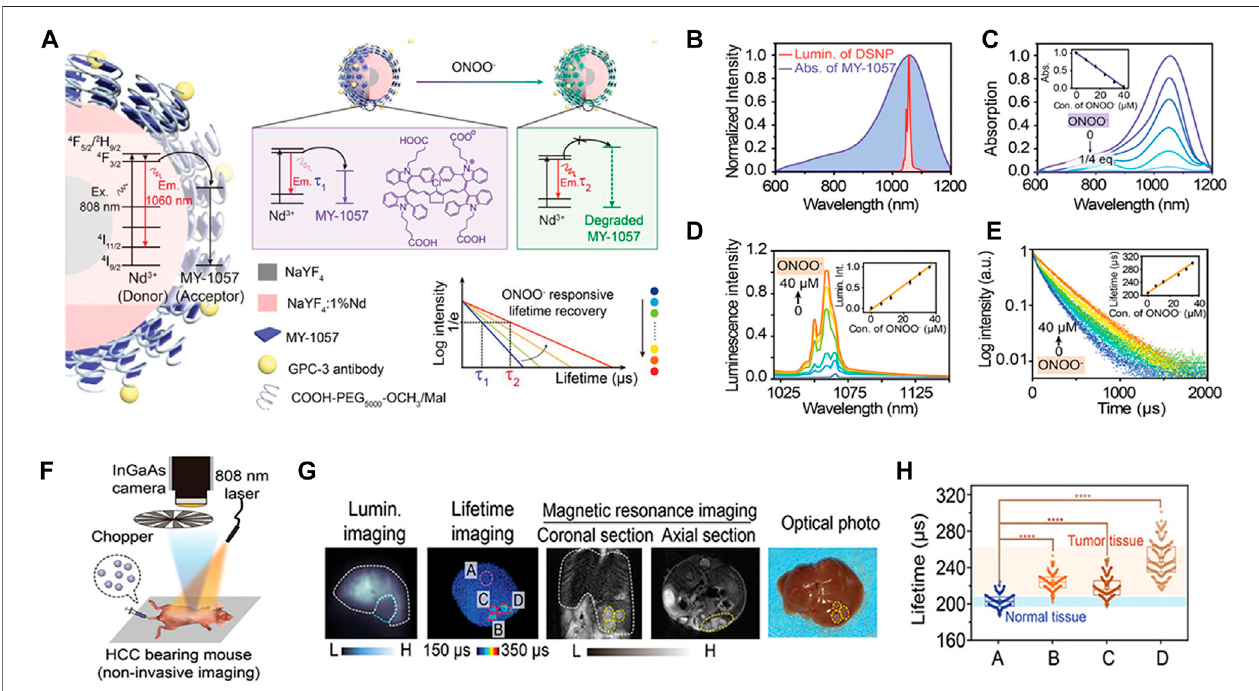
FIGURE 10 | Lifetime-resolved imaging for ONOO − dectection. (A) Schematic illustration of the ONOO − -responsive nanosensor DSNP@MY-1057-GPC-3. In the presence of ONOO − , the structure of the energy acceptor MY-1057 degrades sensitively, leading to the lifetime recovery in NIR-II region. (B) Overlap of the MY-1057 absorption and DSNP luminescence emission spectra. (C) Absorption of MY-1057 as a function of ONOO − (0 – 1/4 equiv.). (D) Luminescence emission intensity and (e) lifetimeresponseofDSNP@MY-1057-GPC-3at1,060 nmasafunctionONOO − concentration. (F) Insitu HCCtumordetectionbynoninvasiveimagingsetupafter administration of DSNP@MY-1057-GPC-3 nanosensor. (G) Noninvasive intensity-based imaging, lifetime-based imaging of a mouse bearing multiple HCC lesions and optical photo of the dissected liver. ROI A: normal hepatic tissue; ROIB – D: tumor lesions distinguished from lifetime imaging. (H) Lifetime extracted from ROI A – D of (G) (reproduced from (Zhao et al., 2020) with permission from WILEY-VCH Verlag GmbH and Co., KGaA, Weinheim).